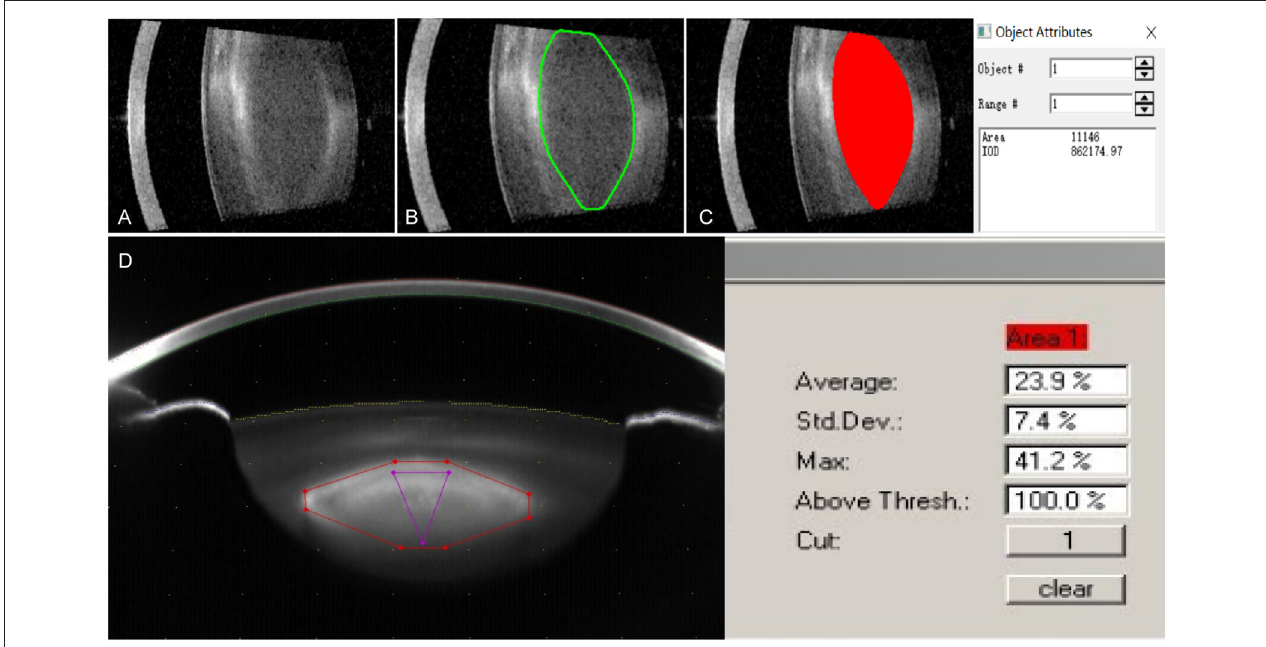
FIGURE 1 | The lens image of the IOLMaster 700 was exported to the Image-Pro ® Plus software for measuring the lens opacity degree in the region of interest indicated by the red area. (A) The lens images obtained by the IOLMaster 700; (B) Selected lens nucleus area of the IOLMaster 700; (C) The optical density (OD) value of the lens nucleus density was analyzed by Image-Pro ® Plus software; and (D) The lens image was obtained by the